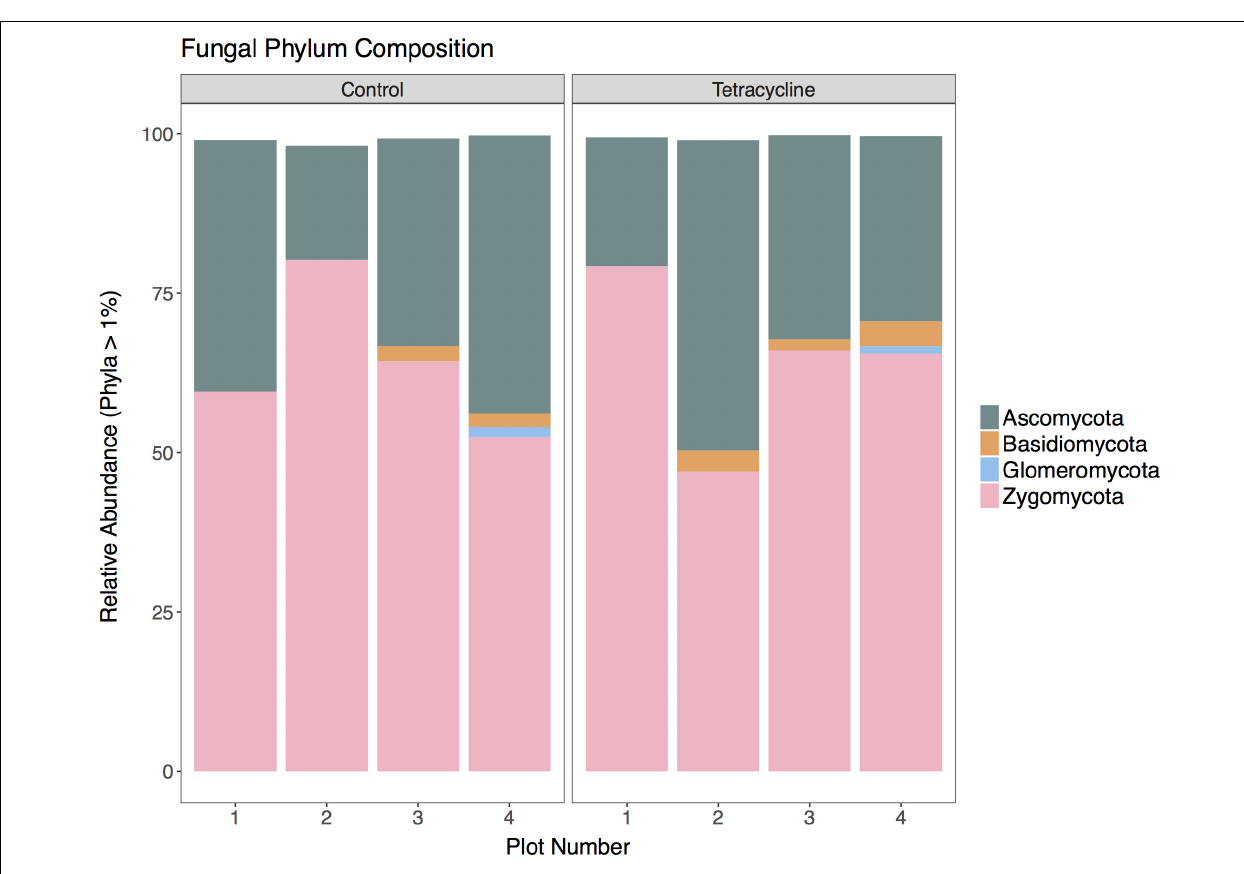
FIGURE 4 | Fungal community composition at the phylum level for control and tetracycline samples. Only phyla with relative abundance higher than 1% are shown. Taxa with significant difference between control and tetracycline samples are marked with ∗ in the legend (paired t -test, p <